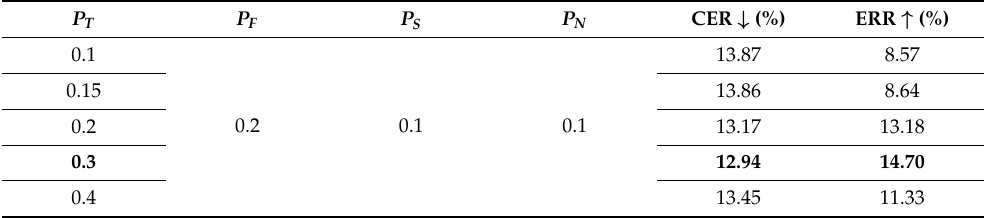
Table 8. ASR Performance comparison according to the variations of P T in the pretraining of the SVR extractor. All the results are from training the ASR model using the pretrained SVR extractor kept frozen. We report on the KsponSpeech ASR performance (Matched-SVR1K). The respective bolds represent the best hyperparameter and performance.